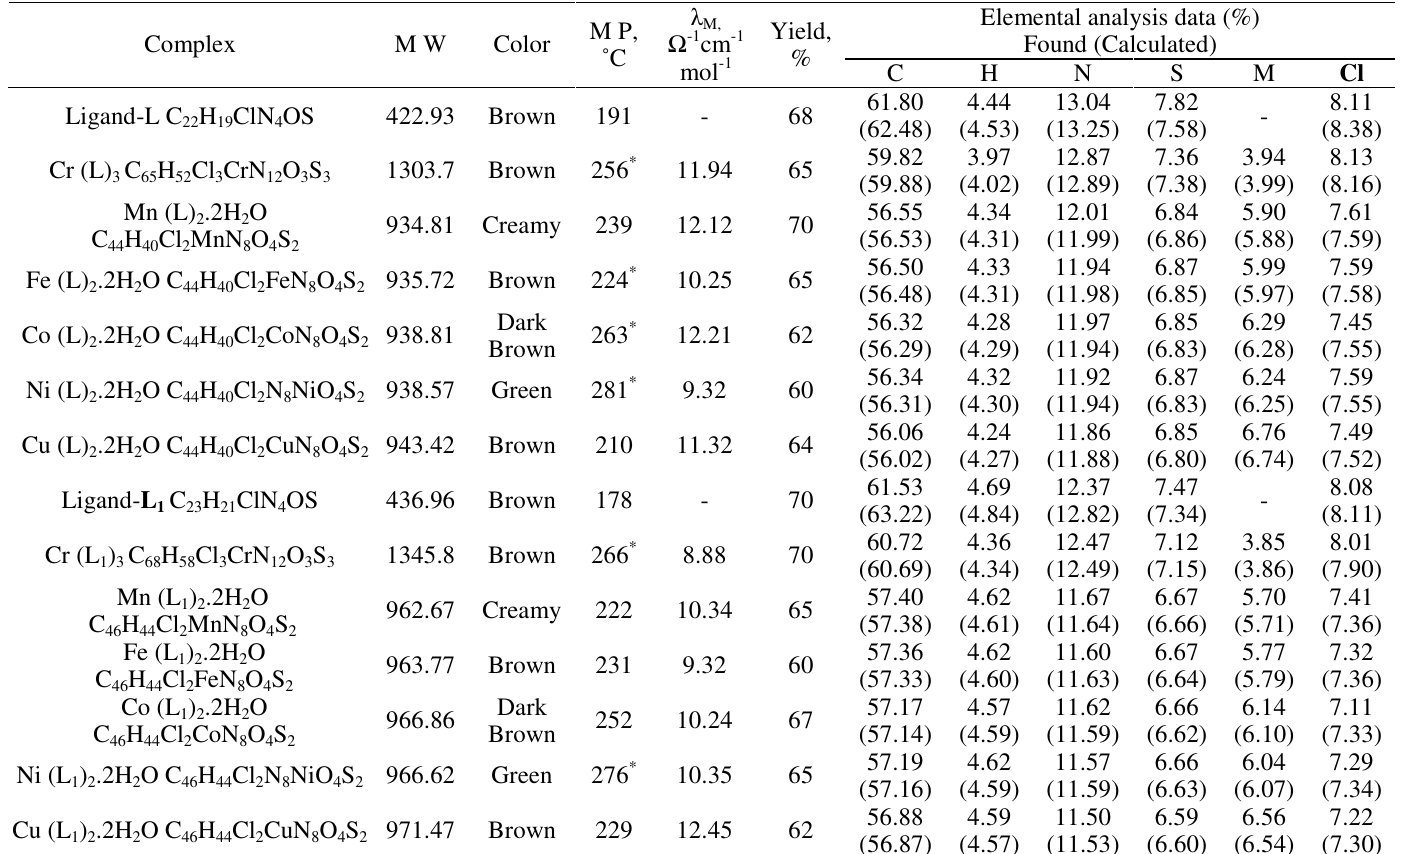
Table 1. Analytical data and physical properties of complexes